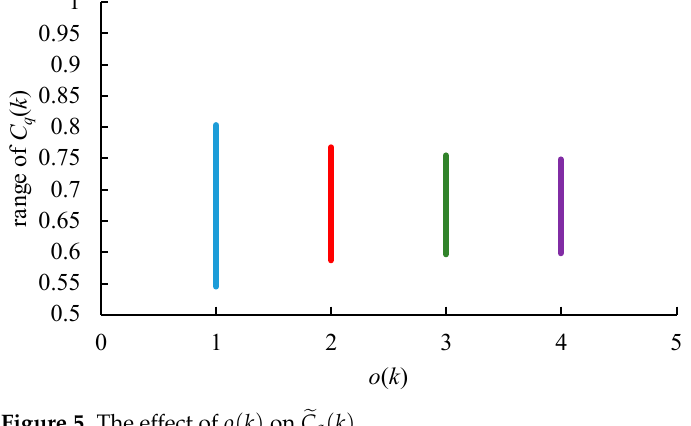
Figure 5. The effect of o ( k ) on (cid:101) C q ( k )